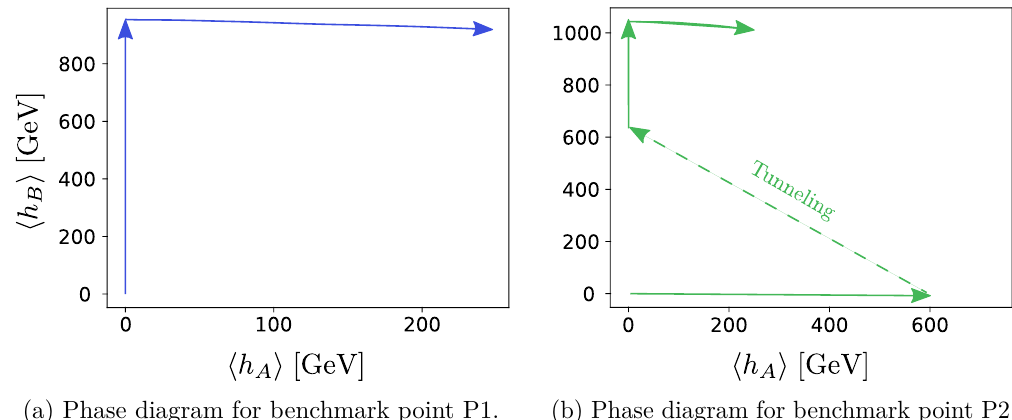
Figure 1. Evolution of the global minimum of the effective potential (2.5) for the two benchmark points in table 1 with the opposite signs of σ . On the right panel dashed arrow connects two degenerate minima, separated by the potential